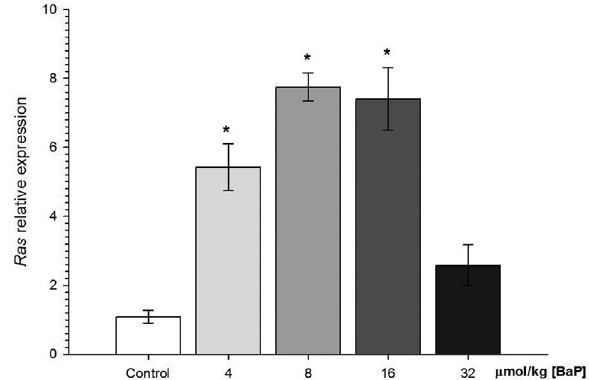
Figure 2 - Histopathological alteration index (HAI) of C. macropomum liver after exposure to different concentrations of B[a]P. Indexes are in ac- cordance with Poleksic and Mitrovic-Tutundic (1994). *Indicates signifi- cant differences compared to control group (corn oil) (p < 0.05). Kruskal-Wallis test was used.